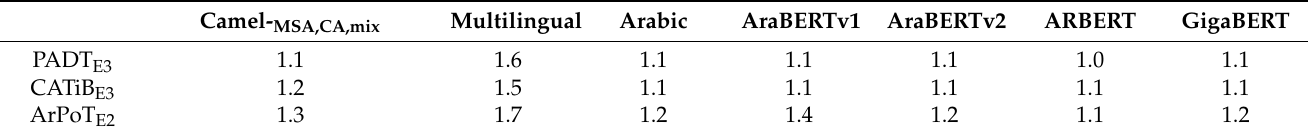
Table 12. Average number of sub-words provided by each model’s tokenizer. Camel- MSA,CA,mix